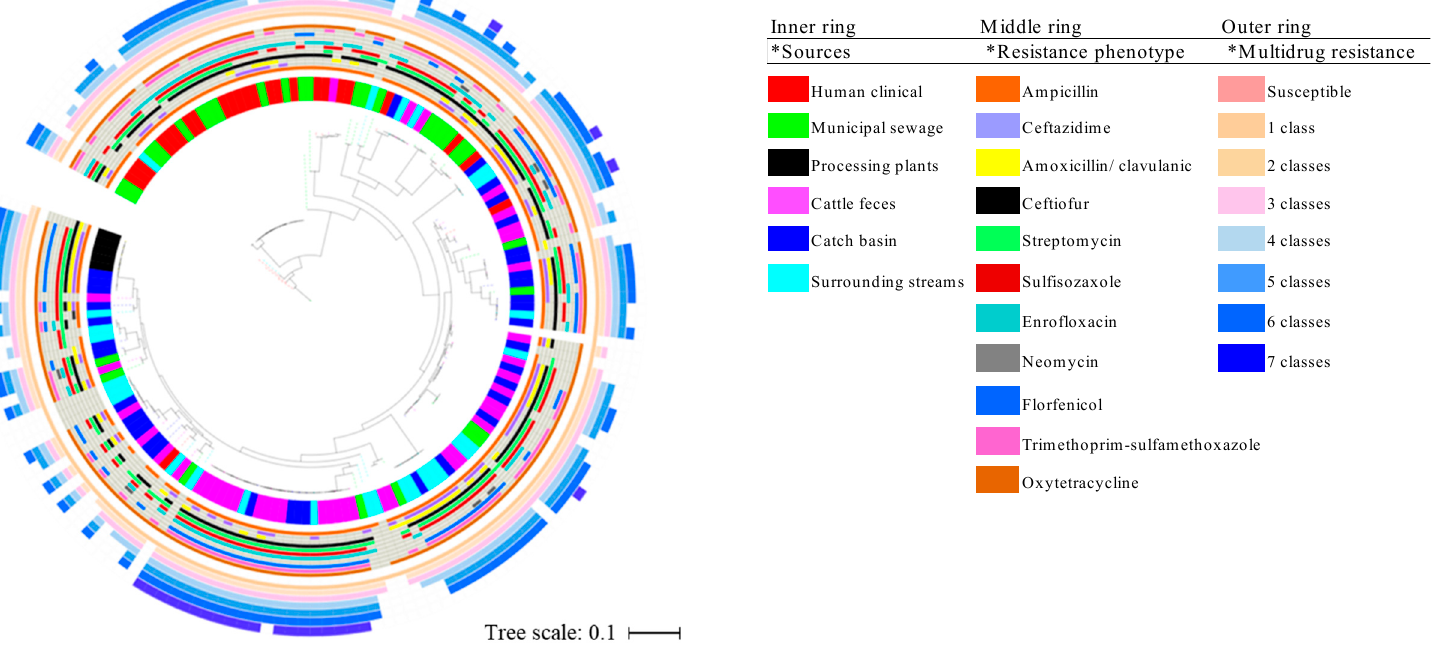
Figure 3. Phylogenetic tree generated on the basis of single-nucleotide polymorphisms (SNPs) of the core genes of 162 E. coli isolates obtained from multiple segments of the beef production system and human-associated isolates with reference genome E. coli str. K-12 substr. MG1655 (GenBank accession # GI: 545778205 / U00096.3). Inner, middle ring, and outer rings are representative of isolate sources, phenotypic antimicrobial, and multidrug resistance, respectively.